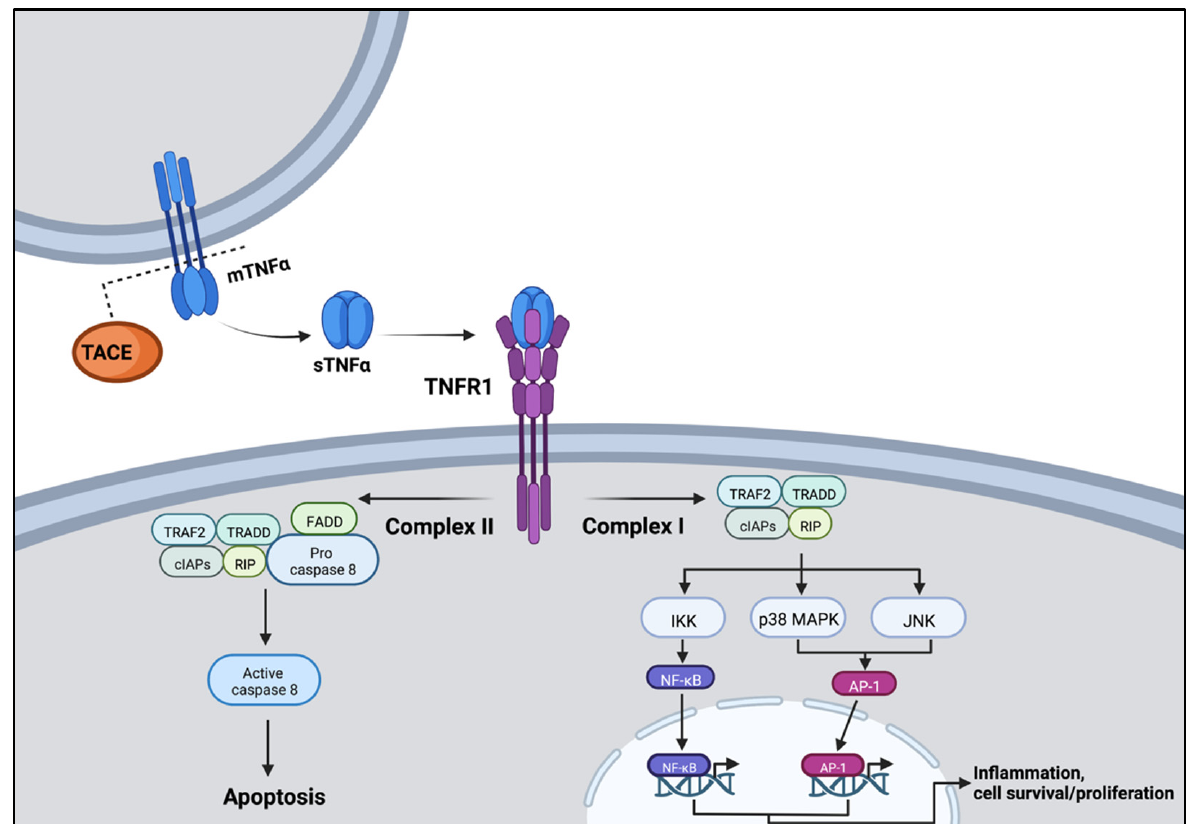
Figure 2. Activation of the TNFR1 receptor by soluble TNF α (sTNF α ). Activation of TNFR1 results in recruitment of TNFR1-associated death domain adapter protein (TRADD). Different complexes may then arise based on protein interactions resulting in downstream activation of pro-inflamma- tion and programmed cell death. Image created using BioRender.